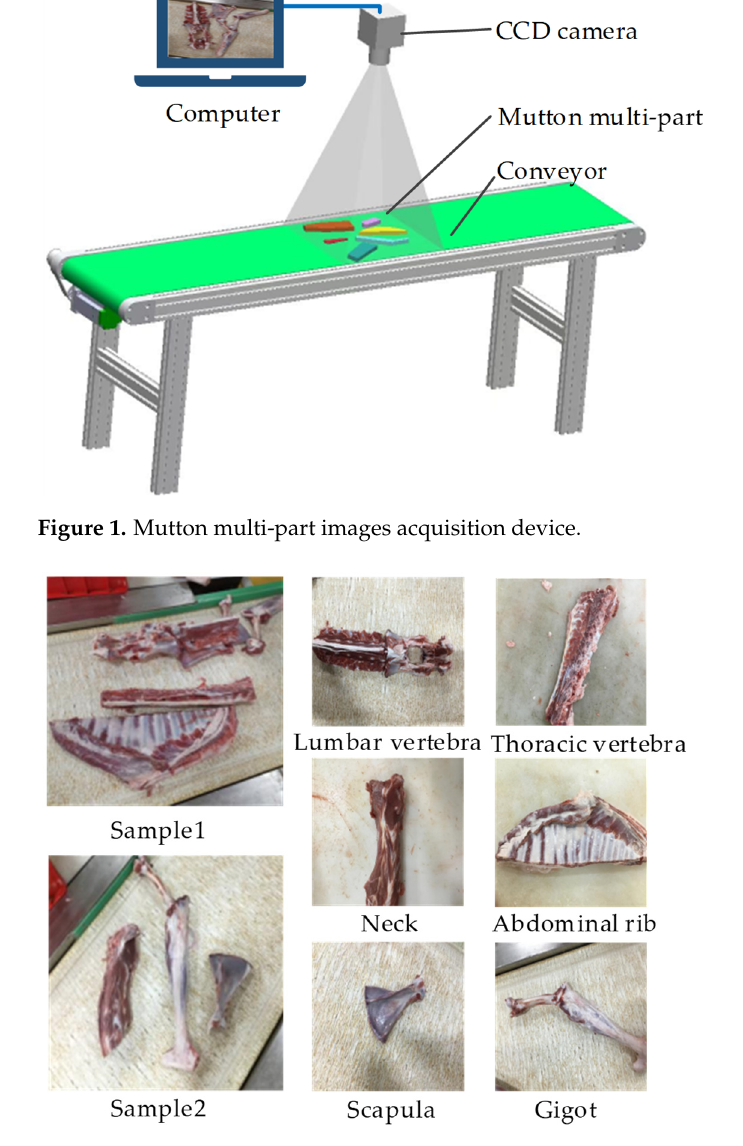
Figure 2. Sample of mu tt on multi-part images.